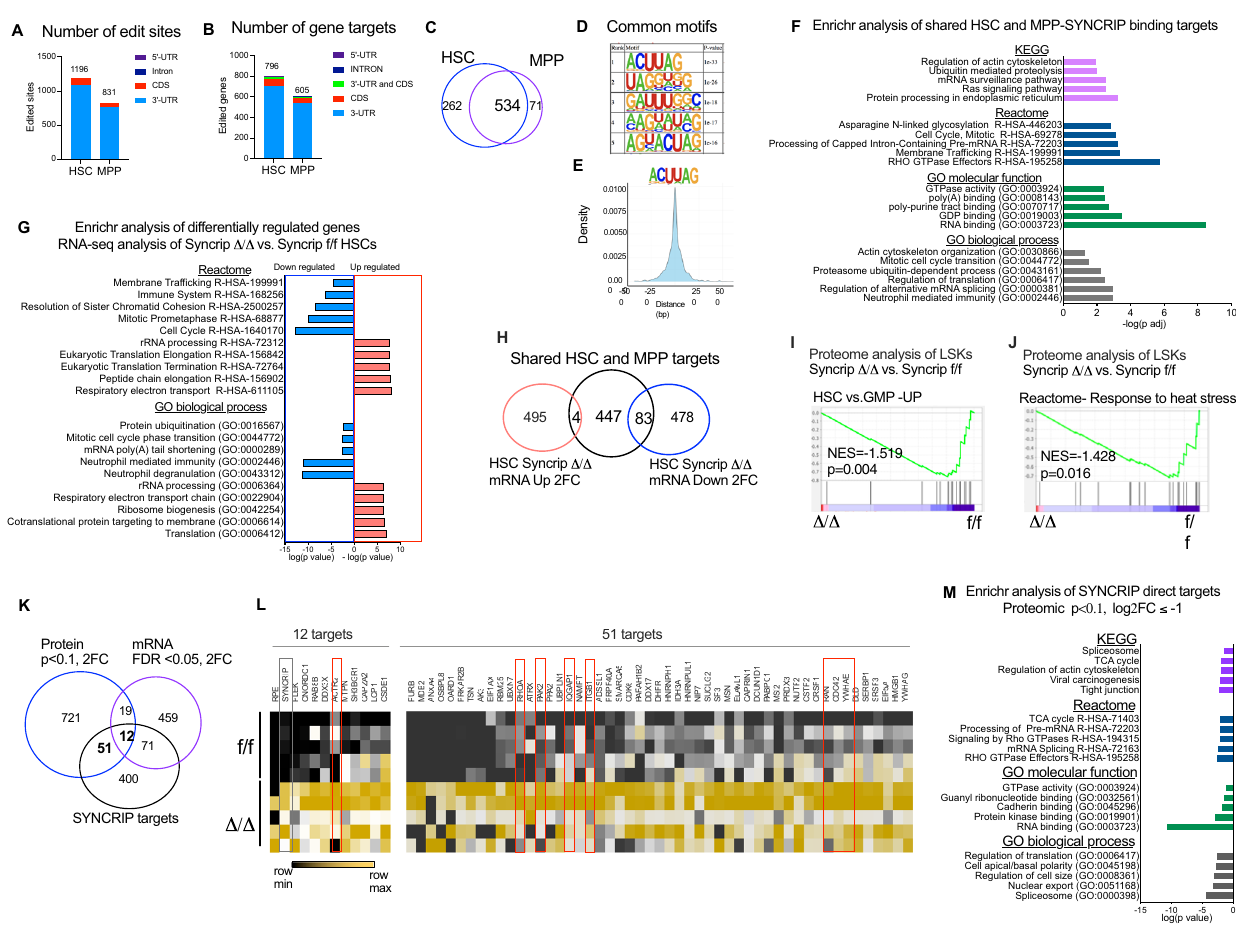
Fig. 5 | Multi-omics analysis identi fi es SYNCRIP functional targets in HSCs. A Number of SYNCRIP-HyperTRIBE signi fi cant edit sites (FDR<0.05 and differ- ential editing frequency (SYNCRIP-ADAR vs. control) ≥ 0.1) and their genic loca- tions in HSC and MPP cells. B Number of target genes with edited sites in ( A ) in hematopoieticstemcell(HSC)andmultipotentprogenitor(MPP). C Venndiagram of SYNCRIP target mRNAs identi fi ed in HSC andMPP:534shared targets, 262 HSC unique targets and 71 MPP unique targets. D De novo motif search identi fi es SYNCRIP-speci fi c binding motifs enriched in mRNA targets with edited sites in both coding regions (CDS and 3 ’ -UTR). E Probability density function (PDF) plots showing the distance from edits sites to the nearest SYNCRIP motifs as depicted. F Enrichr analysis for GO biological processes, GO molecular function, Reactome and KEGG enrichment of HSC and MPP shared SYNCRIP target genes. X-axis: -log 10 (p value). G Enrichr analysis for GO biological processes and Reactome enrichment of signi fi cant (FDR<0.05) downregulated and upregulated genes in Syncrip de fi cient HSCs. X-axis: Enrichment of downregulated targets negative